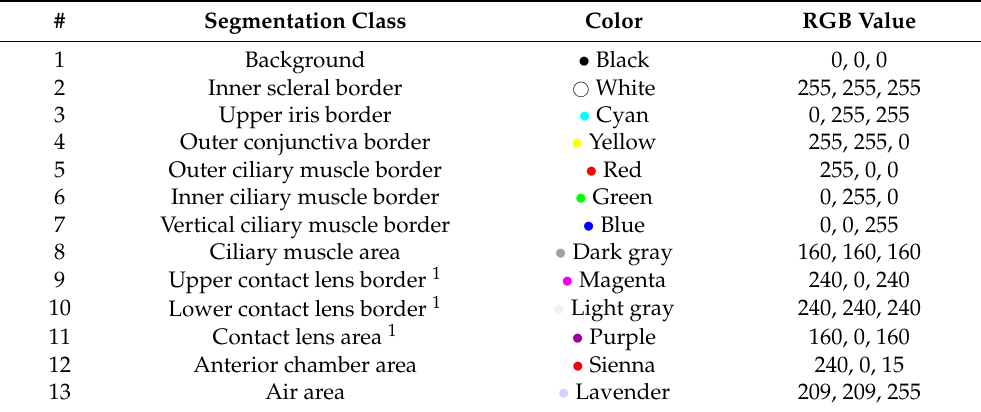
Table 1. Segmentation classes and their corresponding colors, as used in the labeled images (Ground